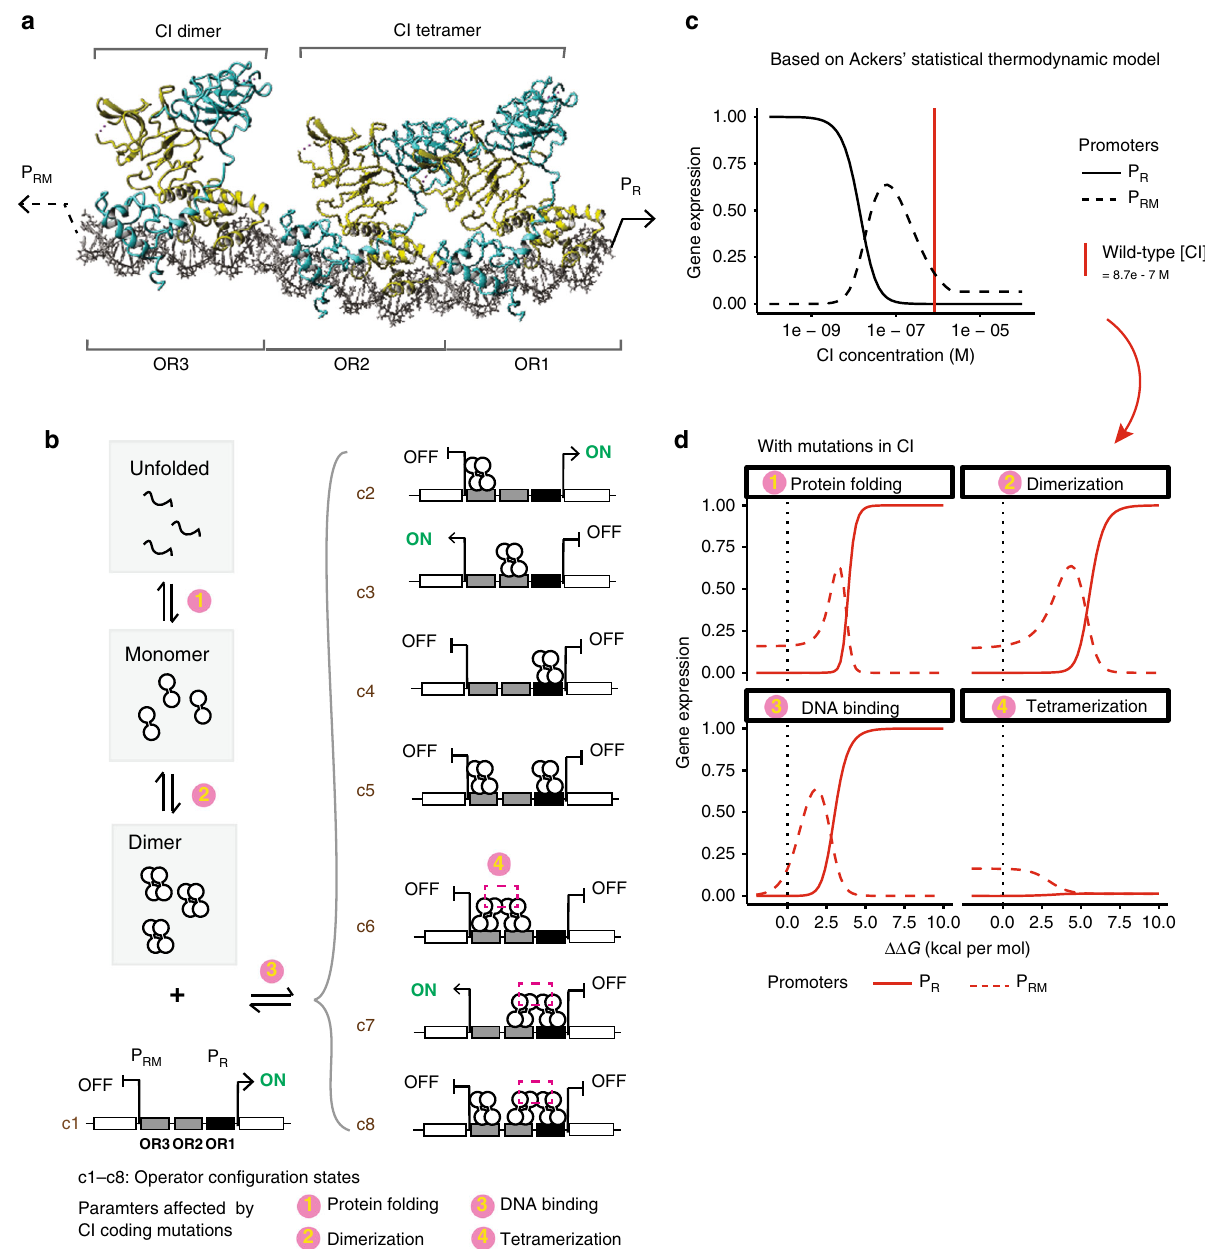
Fig. 1 Genetic interactions in a transcription factor. a CI binds three operators as a dimer with two dimers also forming a tetrameric complex. Cyan and yellow distinguish the two monomers of each dimer. b Statistical thermodynamic model of gene regulation by the lambda repressor (CI). CI exists as unfolded, folded monomer, free dimer and dimers that are bound to operators. The partitioning of these molecules depends on Gibbs free-energy differences between states. c Dose – response curves of the P R and P RM promoters. d Mutations result in additive changes in the free energy of protein folding, dimerization, DNA binding and tetramerization. When only one free-energy term is altered, gene expression is altered by the eight plotted relationships. Dotted vertical black lines denote ΔΔ G = 0 (wild type). See also Supplementary Fig. 1. Source data are provided as a Source data fi